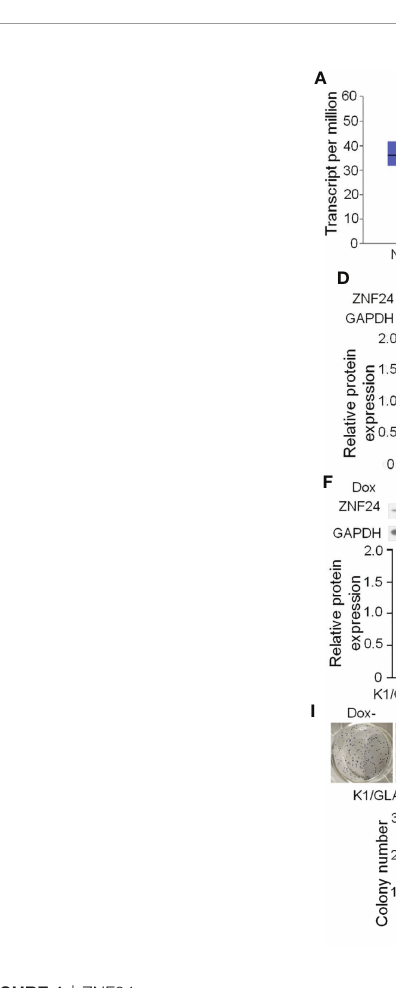
FIGURE 1 | ZNF24 serves as a new suppressor gene of THCA with clinical relevance (A, B) mRNA levels of ZNF24 within the GTEX-derived thyroid samples and TCGA-derived THCA samples; (C) : mRNA expression of ZNF24 in para-tumoral tissues and in tumor tissues; (D) : Western blotting on the ZNF24 level within speci fi c lung tissue samples, T: tumor, N: para-tumor; (E) : Western blotting on the ZNF24 level within speci fi c THCA cells (F) Impacts of DOX-mediated ZNF24 expression within stable BCPAPi and K1/GLAG-66i cells. Immunoblots that contained speci fi c antibodies were used to analyze speci fi c cells-derived whole-cell lysates; (G, H) ZNF24 ectopic expression inhibited K1/GLAG-66i and BCPAPi cells cell viability. The K1/GLAG-66i (F) and BCPAPi cells (G) (1 × 10 3 ) were exposed to 48 h of 1 µg/ml DOX treatment or not, and CCK-8 assay was conducted to detect cell viability at speci fi c time points; (I) ZNF24 suppressed the ability of form colonies in BCPAPi and K1/GLAG-66i cells. K1/GLAG-66i and BCPAPi cells were exposed to 10 days of DOX treatment prior to colony formation assay; (J) ZNF24 suppressed the ability to form spheres in BCPAPi and K1/GLAG-66i cells. Typical sphere formation image for BCPAPi and K1/ GLAG-66i cells (upper), as well as sphere formation statistic image (lower). Values are obtained from three independent assays, while unpaired t-test was used for analysis. Error bars = SD. *P < 0.05, ** P <